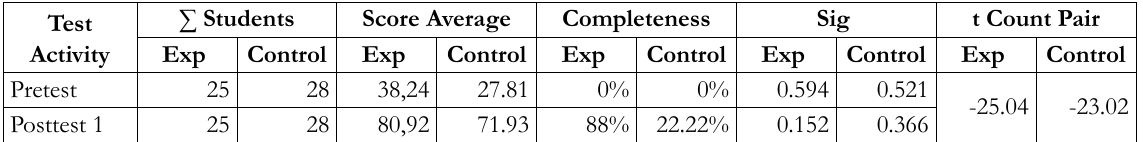
Table 4. Pretest and posttest 1 results of experiment and control